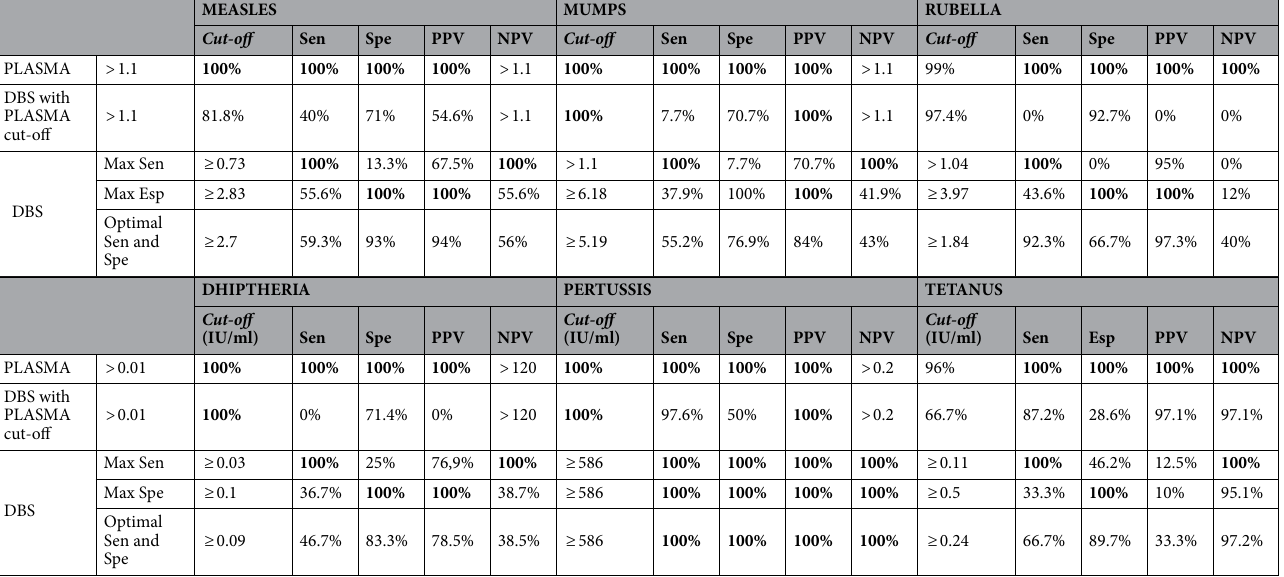
VirClia cut-off for 5 pathogens: rubella (-50%), diphtheria (− 45.2%), mumps (− 42.9%), measles (− 28.6%) and tetanus (− 4.8%). The only exception was pertussis, showing a similar low number of protected subjects than in plasma. When the optimal cut-off showed in Table 3 for each pathogen was applied in DBS (Fig. 2 option D), the percentage of immunized among these 42 children was lower than using plasma to diphtheria (− 35.7%), mumps and measles (− 23.8%) and rubella (− 4.8%), was slightly higher (+ 2.4%) to tetanus, and similar to pertussis. Estimated immunization level in DBS of 143 children and adolescents. To study the protection